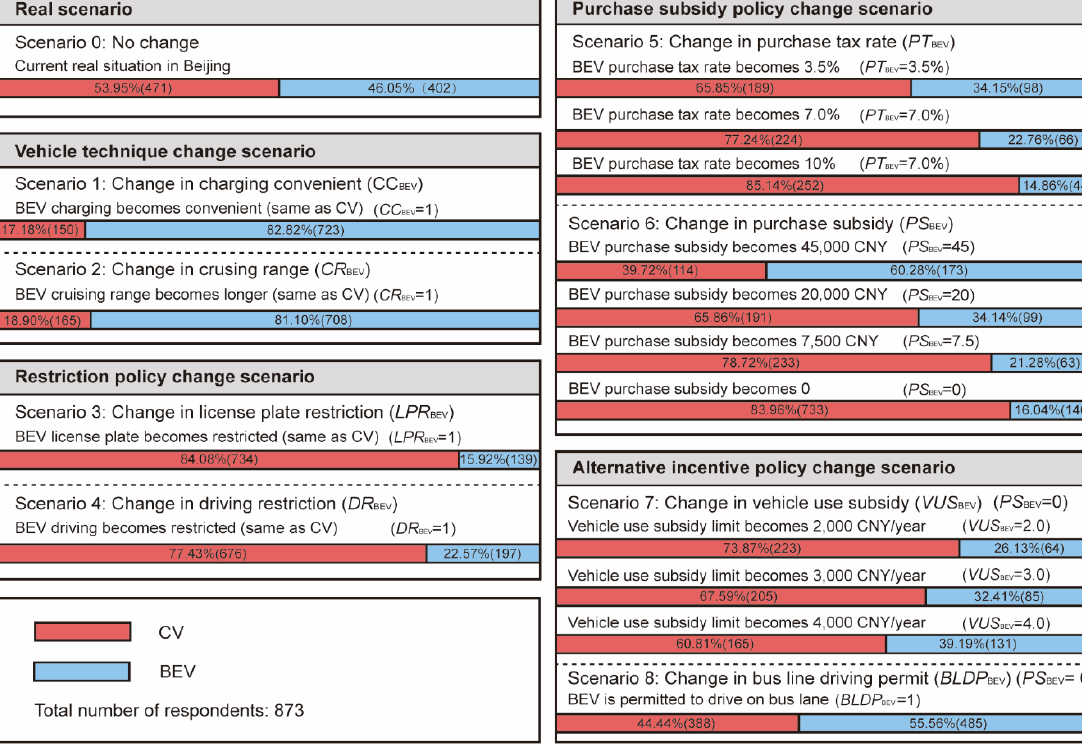
Figure 6. Statistics of basic information in the survey. 4. Results and Analysis